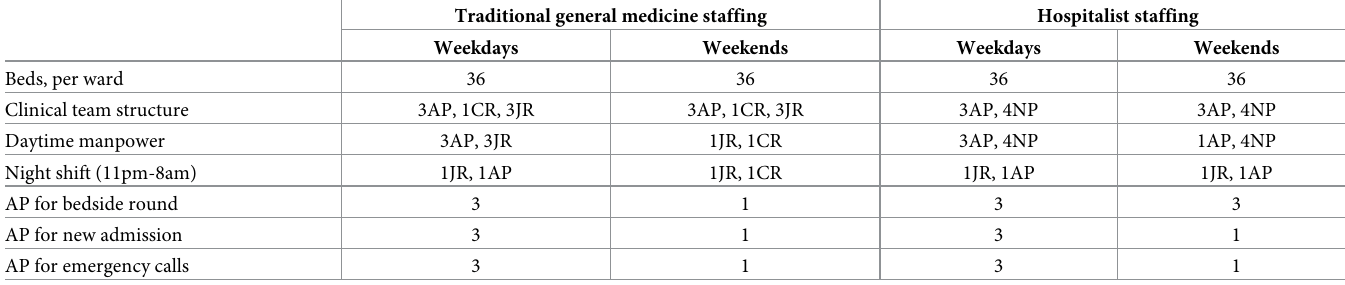
Table 1. Comparison the settings of the traditional general medicine and hospitalist staffing on weekdays and